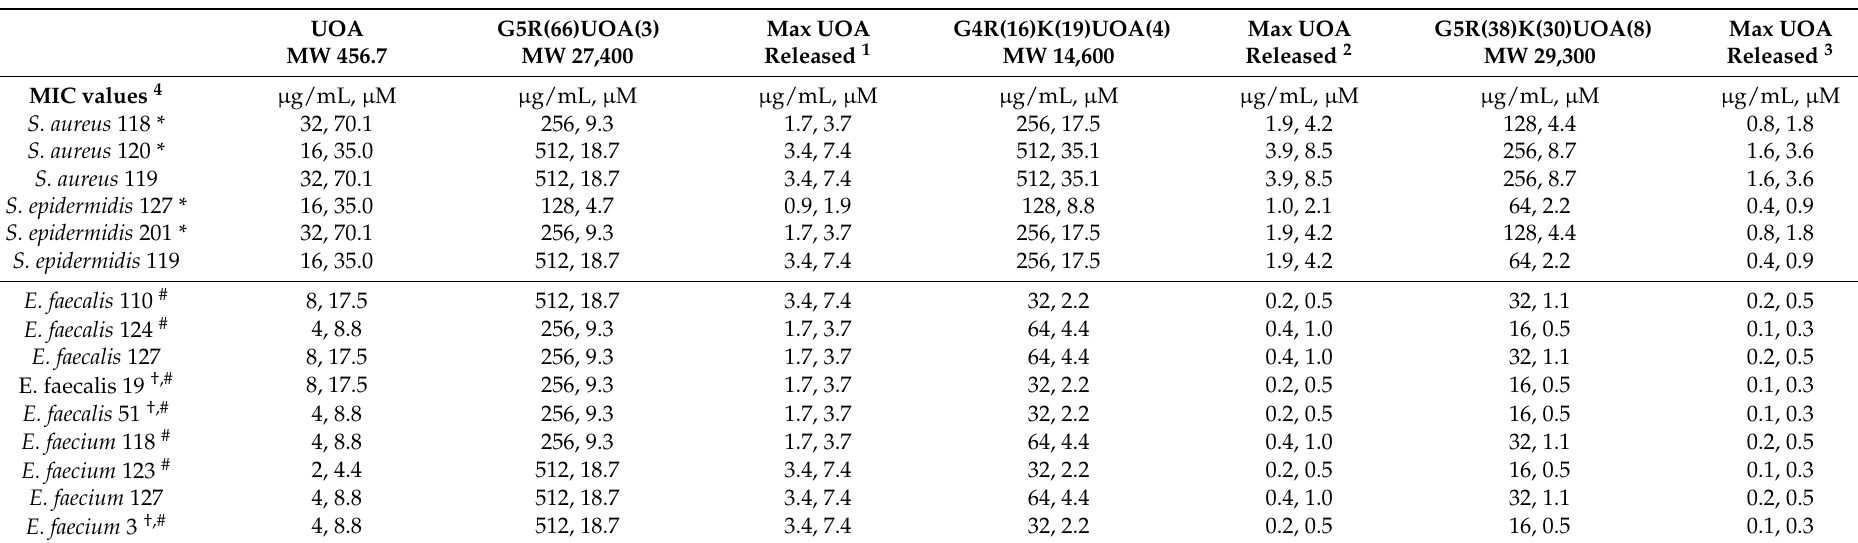
Table 3. Minimum inhibitory concentration (MIC) values of the three prepared UOACDs and of UOA, expressed as µ g/mL and millimolarity (mM), against the Gram-positive strains tested in the study, and the maximum concentrations of UOA released according to the MIC values observed for each dendrimer complex and according to its release profile as reported in Table